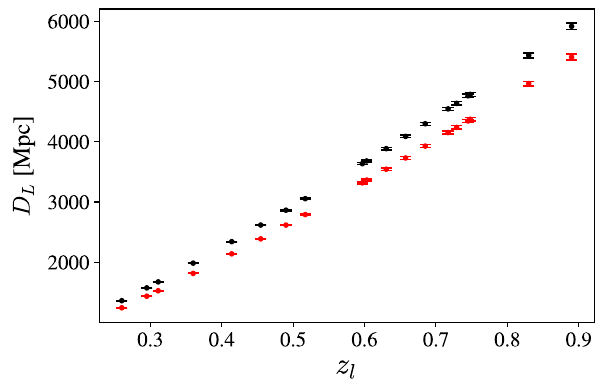
Fig. 2 Time-delay angular diameter distance measurements of strong gravitational lensing systems compiled by [45] (black points) and [46] (red